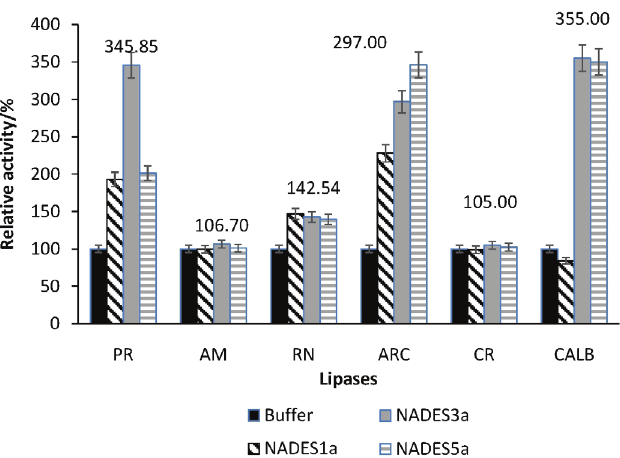
Fig. 2 – Screening of different lipases with sugar-based NA- DESs against buffer as a control reference. Lipase from porcine pancreas (PR), lipase from Candida rugosa (CR), Amano li- pase PS, from Burkholderia cepacia (AM), lipase from Rhizo- pus niveus (RN), lipase acrylic resin from Candida antartica (ARC) (recombinant, expressed in Aspergillus niger), Lipase B Candida antartica immobilized on Immobead 150, recombinant from Aspergillus oryzae